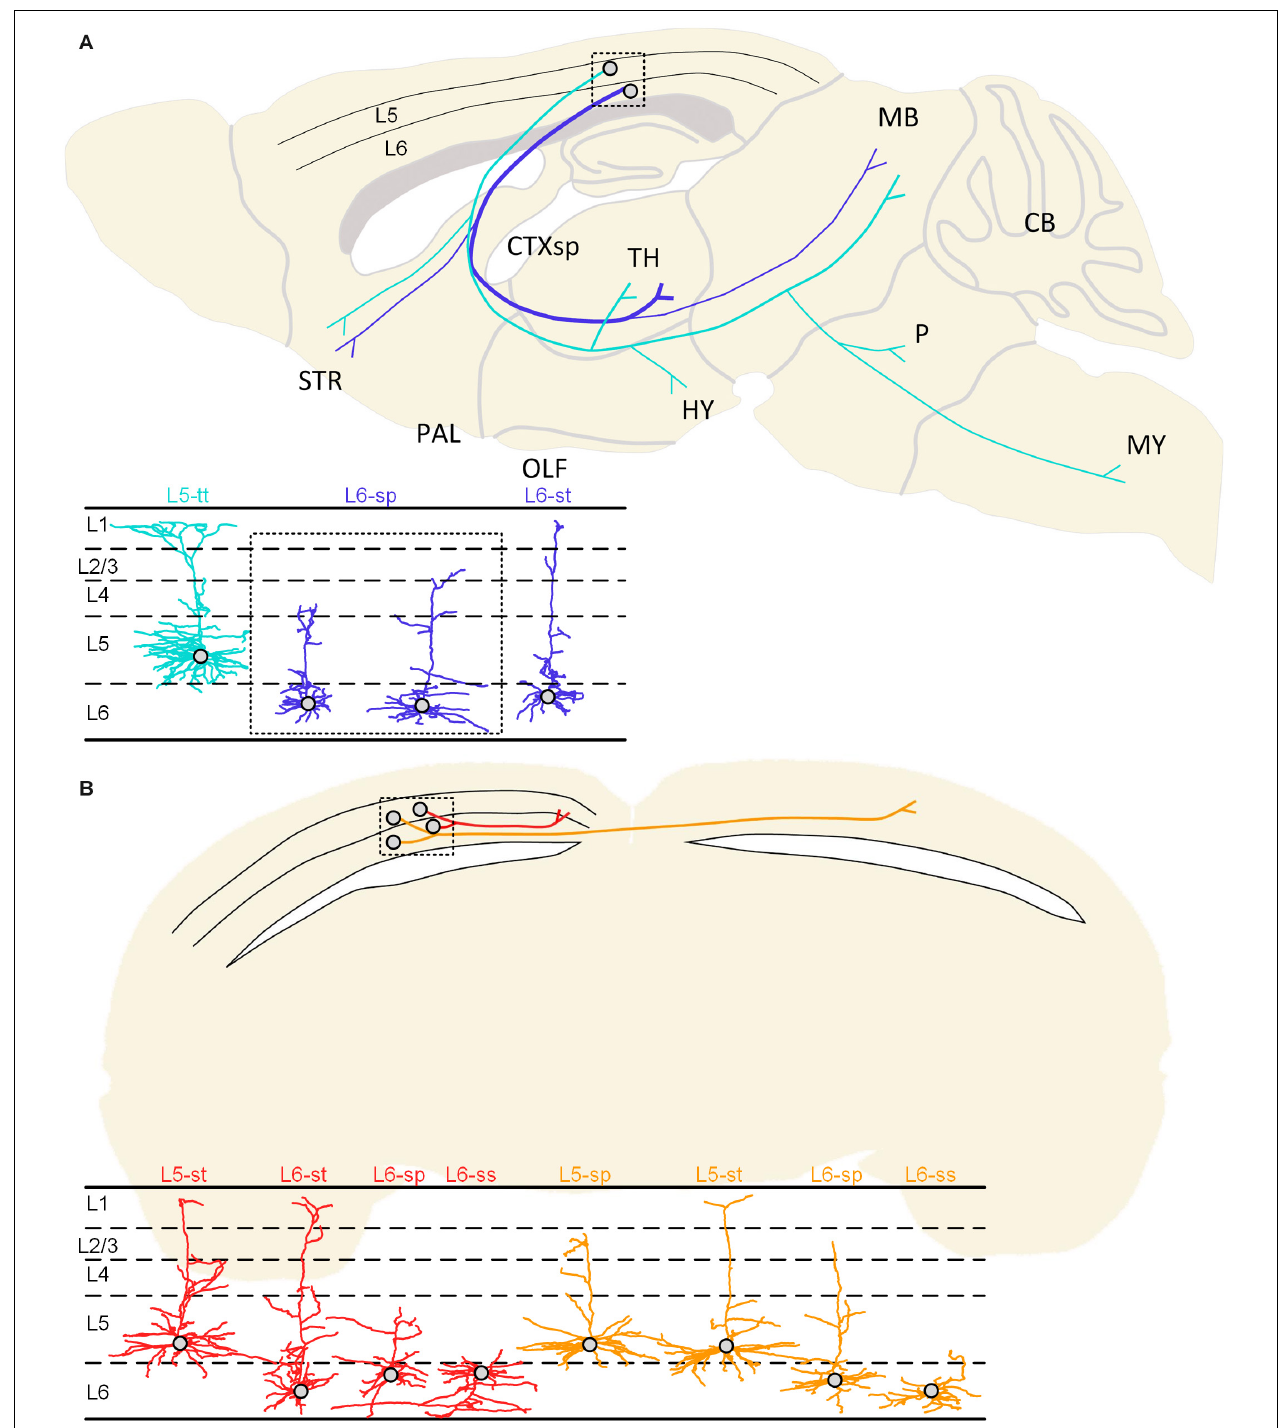
FIGURE 7 | Summarized projection patterns of the studied neurons in the visual cortex. (A) Two typical projection patterns of corticofugal projection neurons. The cyan-colored neuron shows a cell body located in L5 of the cortex and the subcerebral projection mode. The same cyan-colored dendrites in the lower left corner indicate the L5-tt type. The blue colored neuron presents soma in the L6 and the corticothalamic projection mode. The blue-colored dendrites may be classified as L6-sp and L6-st types according to the dendritic morphology. (B) The projection patterns of the ipsilateral circuit connection neurons and the callosal projection neurons. The ipsilateral circuit connection neurons (red) with somata located in the 5th or 6th layer of the cortex can be classified as L5-st, L6-st, L6-sp, and L6-ss dendritic types. The callosal projection neurons (orange) with cell bodies located in layer 5 or 6 can be distinguished as L5-sp, L5-st, L6-sp, and L6-ss types.